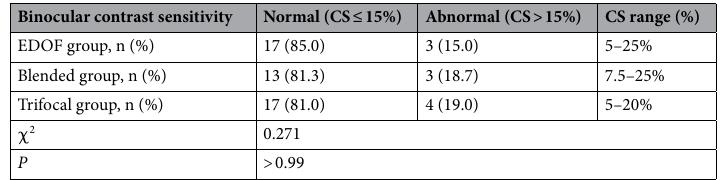
Table 4. Binocular contrast sensitivity of the EDOF group, blended group and trifocal group. CS contrast sensitivity. P > 0.05 means no statistically significant difference between the three groups.